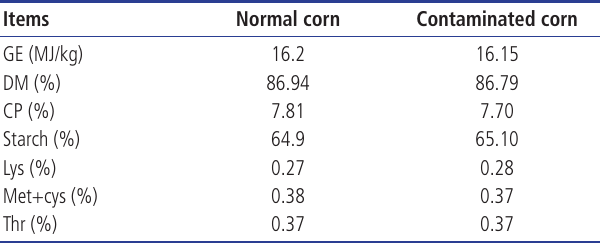
Table 4. The GE and nutrient composition between normal corn and contaminated corn Items Normal corn Contaminated